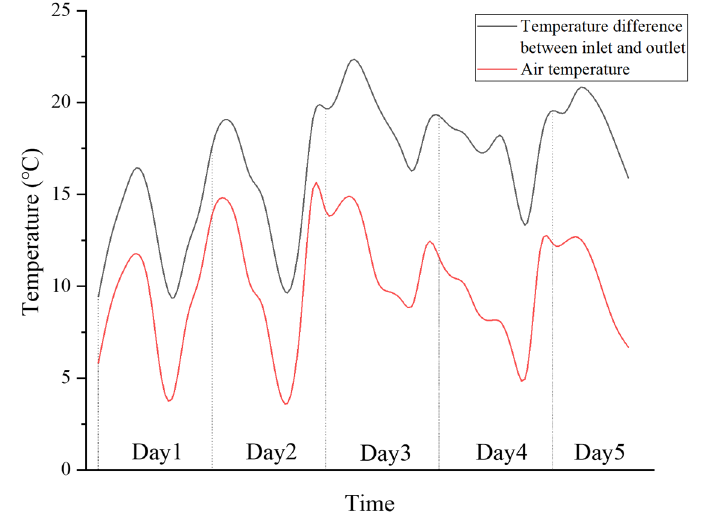
Figure 15. Variation of temperature difference between inlet and outlet at P1.